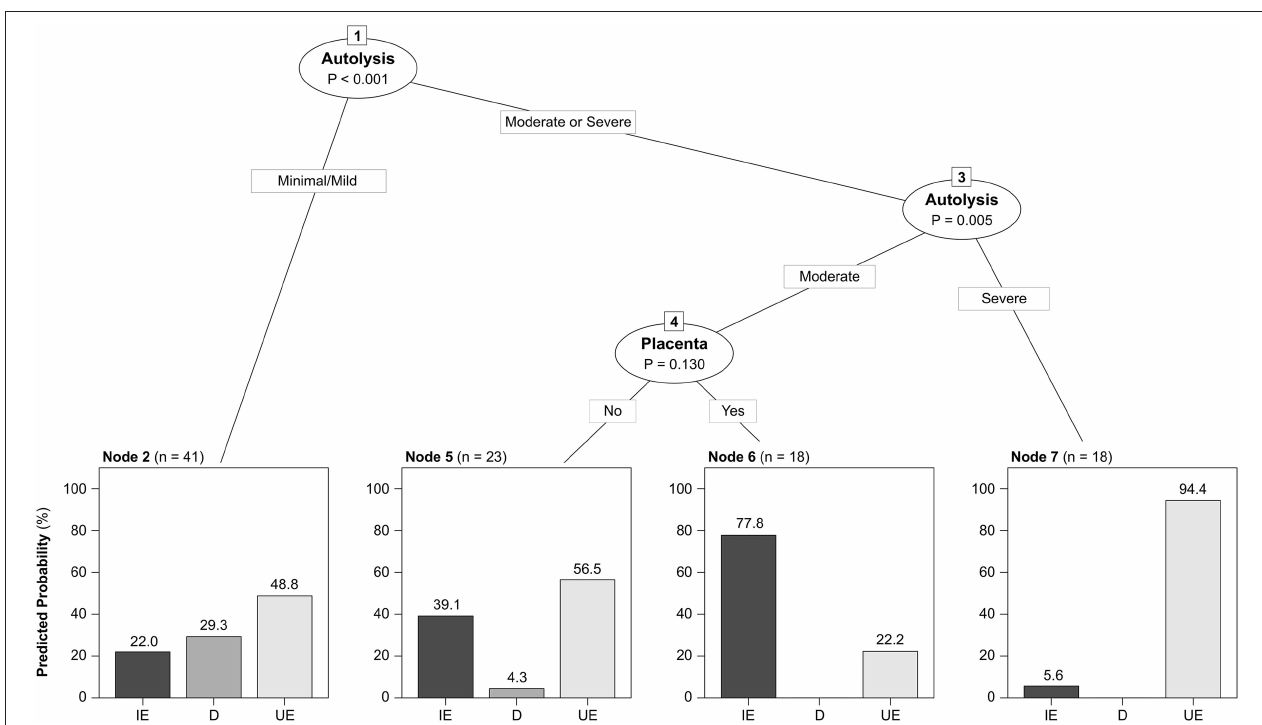
FIGURE 2 | Conditional inference tree fitted by repeated cross-validation showing the predicted conditional distribution of diagnostic categories as a function of the degree of autolysis and the availability of placenta. Node 2 grouped cases with mild/minimal autolysis, in which the predicted probability of reaching an etiologic diagnosis of dystocia was highest. Nodes 5 and 6 grouped cases with moderate autolysis, in which the probability of reaching an etiologic diagnosis of infectious etiology was higher when placenta was available (node 6) versus unavailable (node 5). Node 7 grouped cases with severe autolysis which had higher probability of having an undetermined etiology. IE, Infectious etiologies ( n = 33). D, Dystocia ( n = 13). UE, Undetermined etiology ( n = 54). Fetal mummification was also considered as a potential predictor, but it was not retained in the final tree as it did not improve the classification accuracy.